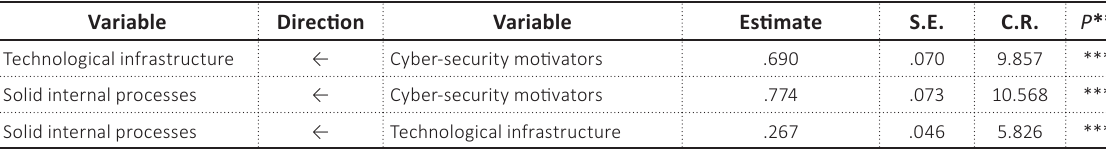
Table 8. Amos results